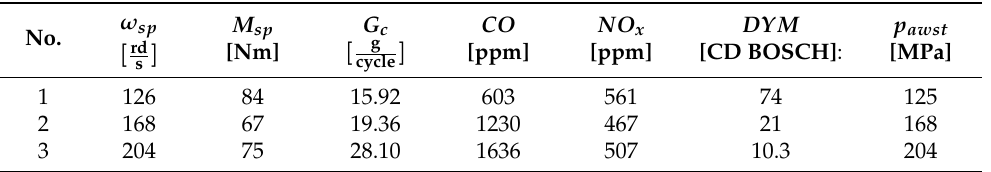
Table 9. Parameters of combustion engine duty points determined for accumulator with capacity V a = 0.04 [m 3 ] (load I).